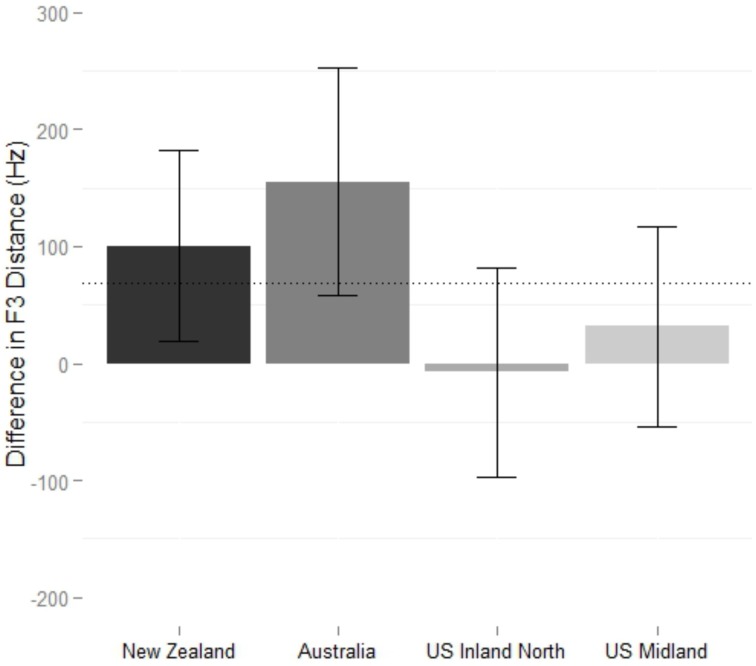
Difference in F3 distance between Midland shadowers and their model across baseline and shadowed tokens on NEAR. Error bars mark 95% confidence intervals. Dotted line represents grand mean of model.